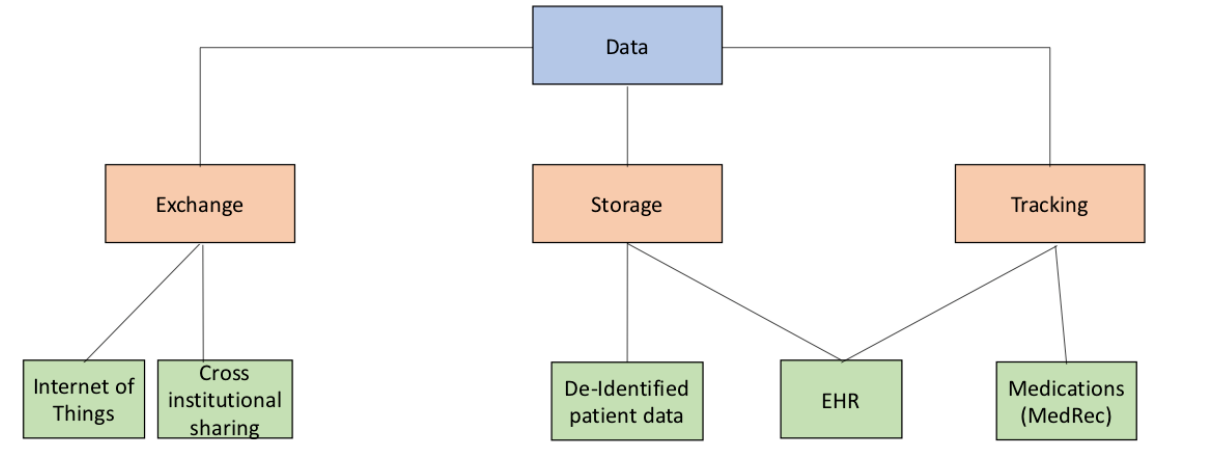
Figure 2. Data exchange tree. EHR: electronic health